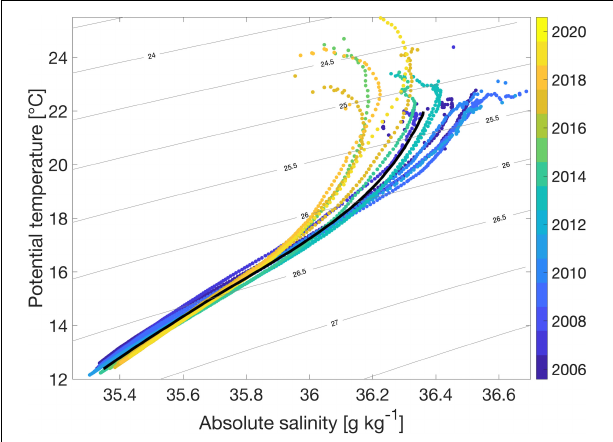
FIGURE 8 | T-S diagram of annual mean potential temperature and absolute salinity values of the upper 200 m in the SETA region (10–20 ◦ S, 5 ◦ W–15 ◦ E). Black line indicates the mean of the time period of